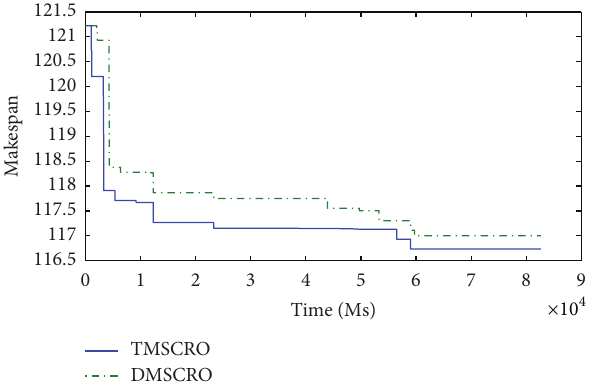
Figure 25: The convergence trace for the randomly generated DAGs with each containing 10 tasks.